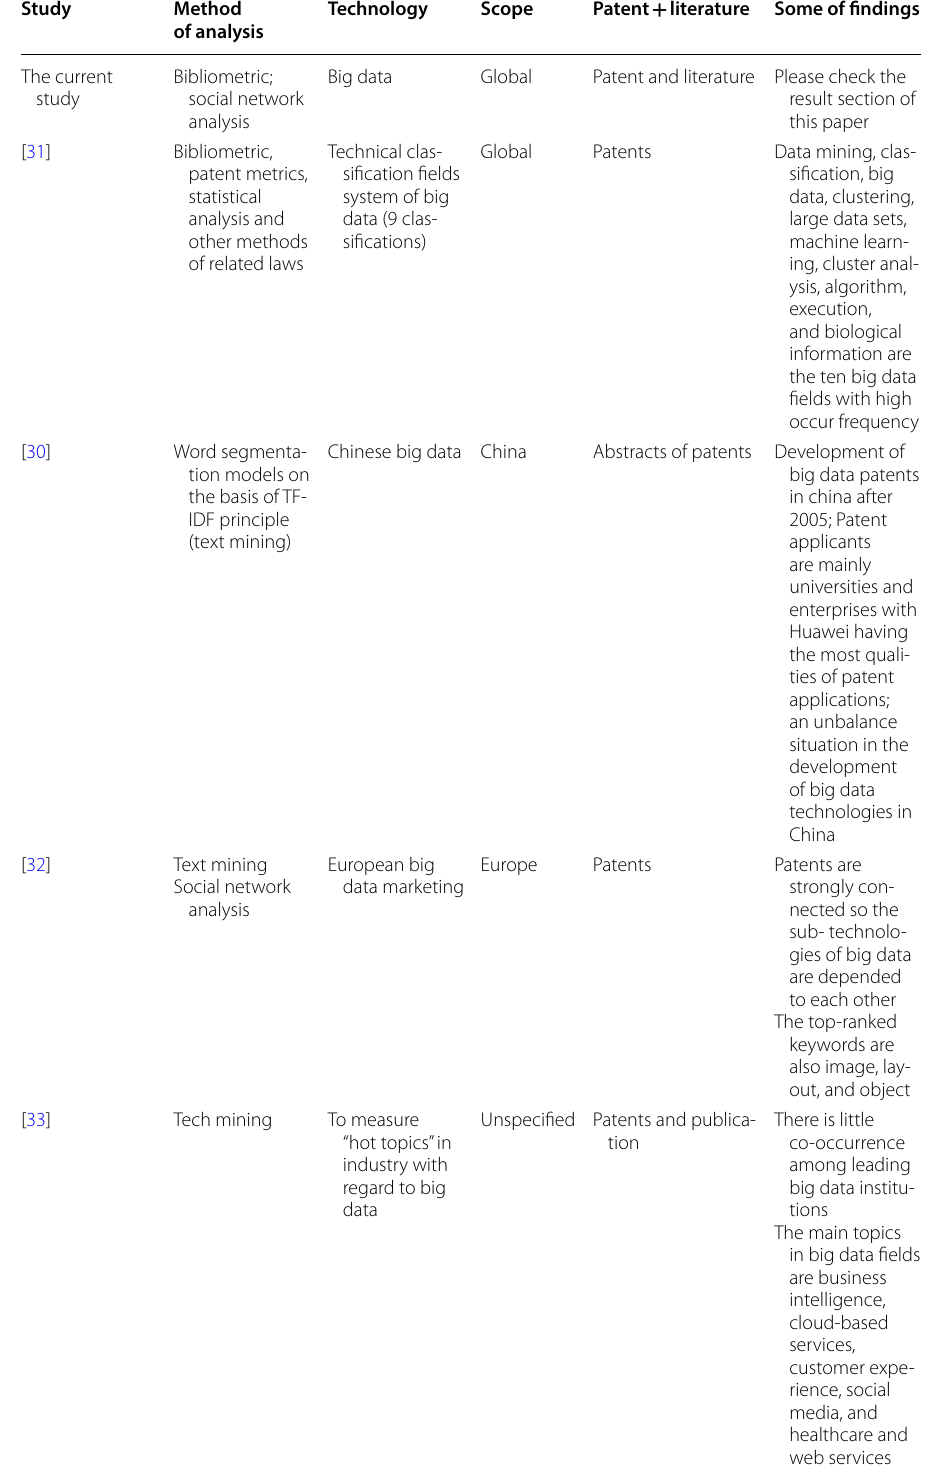
Table 1 A summary of previous studies on big data patenting activities